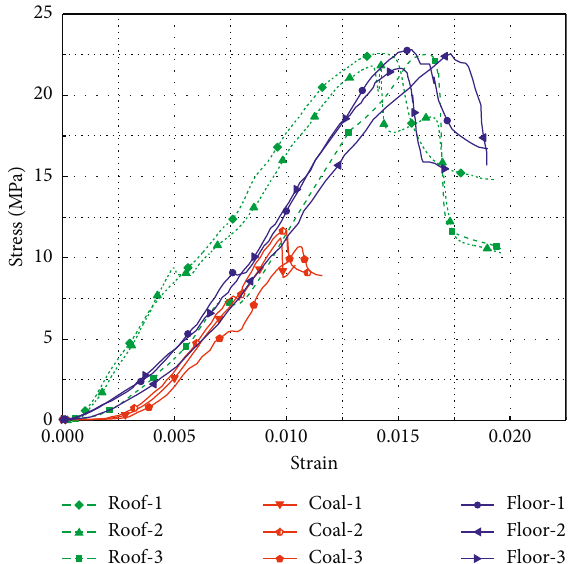
Figure 6: Uniaxial compressive stress-strain curves of coal and rocks.